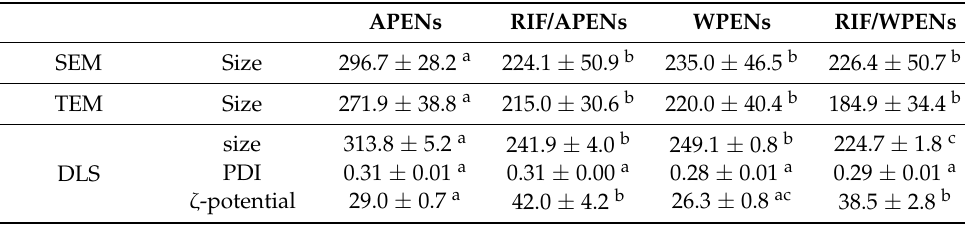
Table 1. Evaluation of the size (nm), PDI, and ζ -Potential of PENs and RIF-loaded